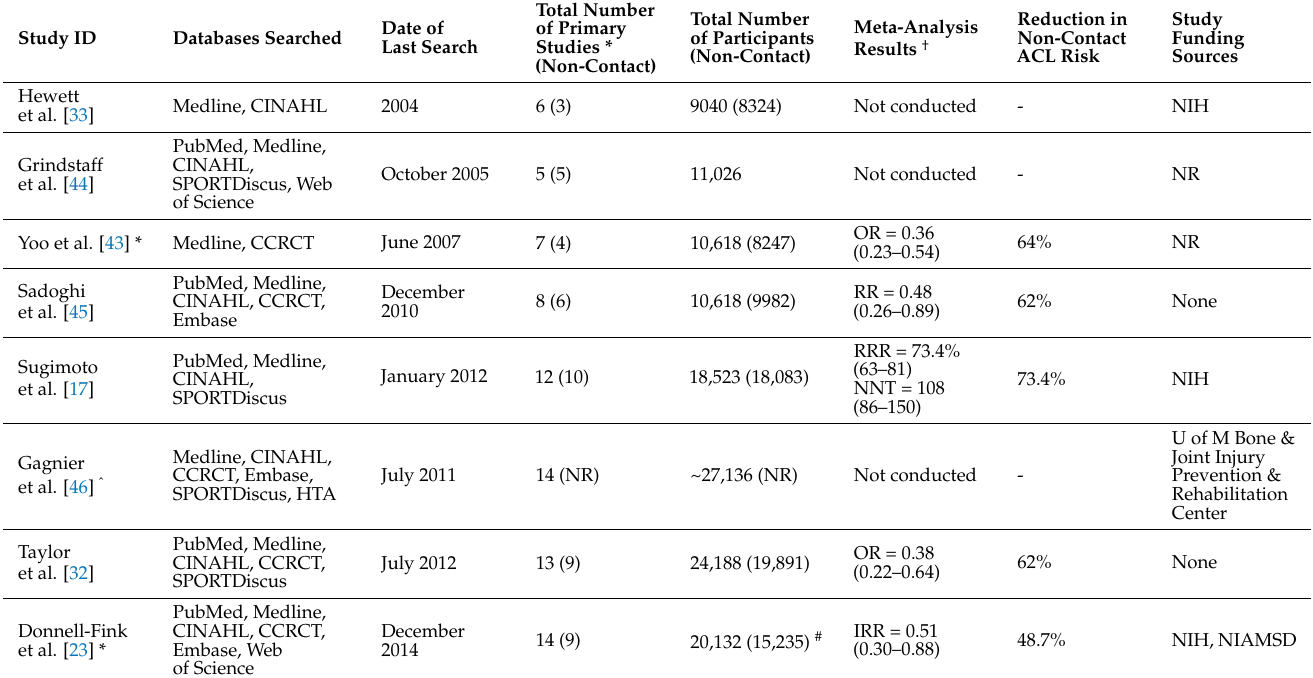
Table 2. Characteristics of the included systematic reviews and